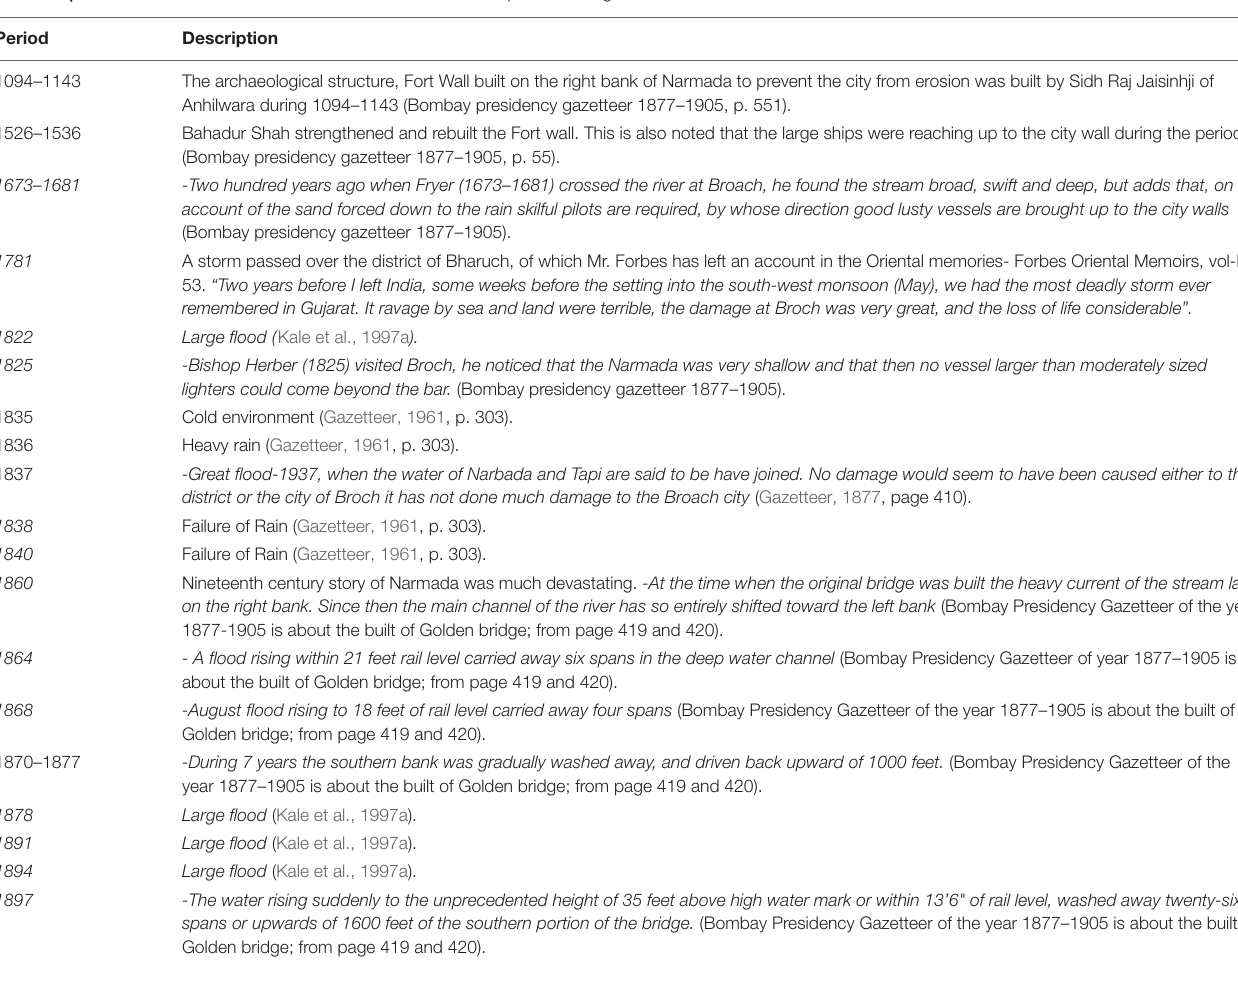
TABLE 6 | Historical records documented for Bharuch town with respect to changes in the Narmada River.